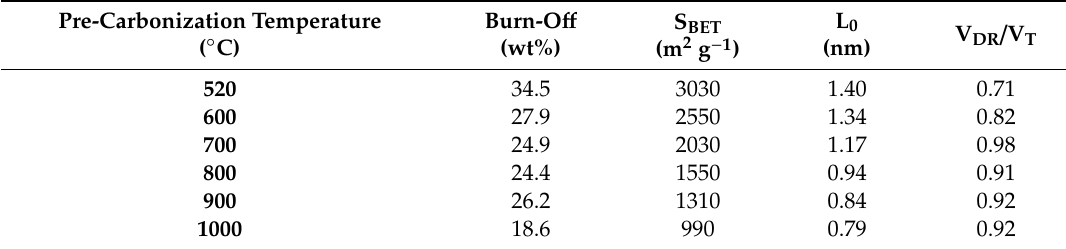
Table 5. Porosity parameters of ACs produced by KOH activation of bituminous coal-derived chars (char/KOH ratio 1:3, reaction temperature 800 °C, soaking 1 h).